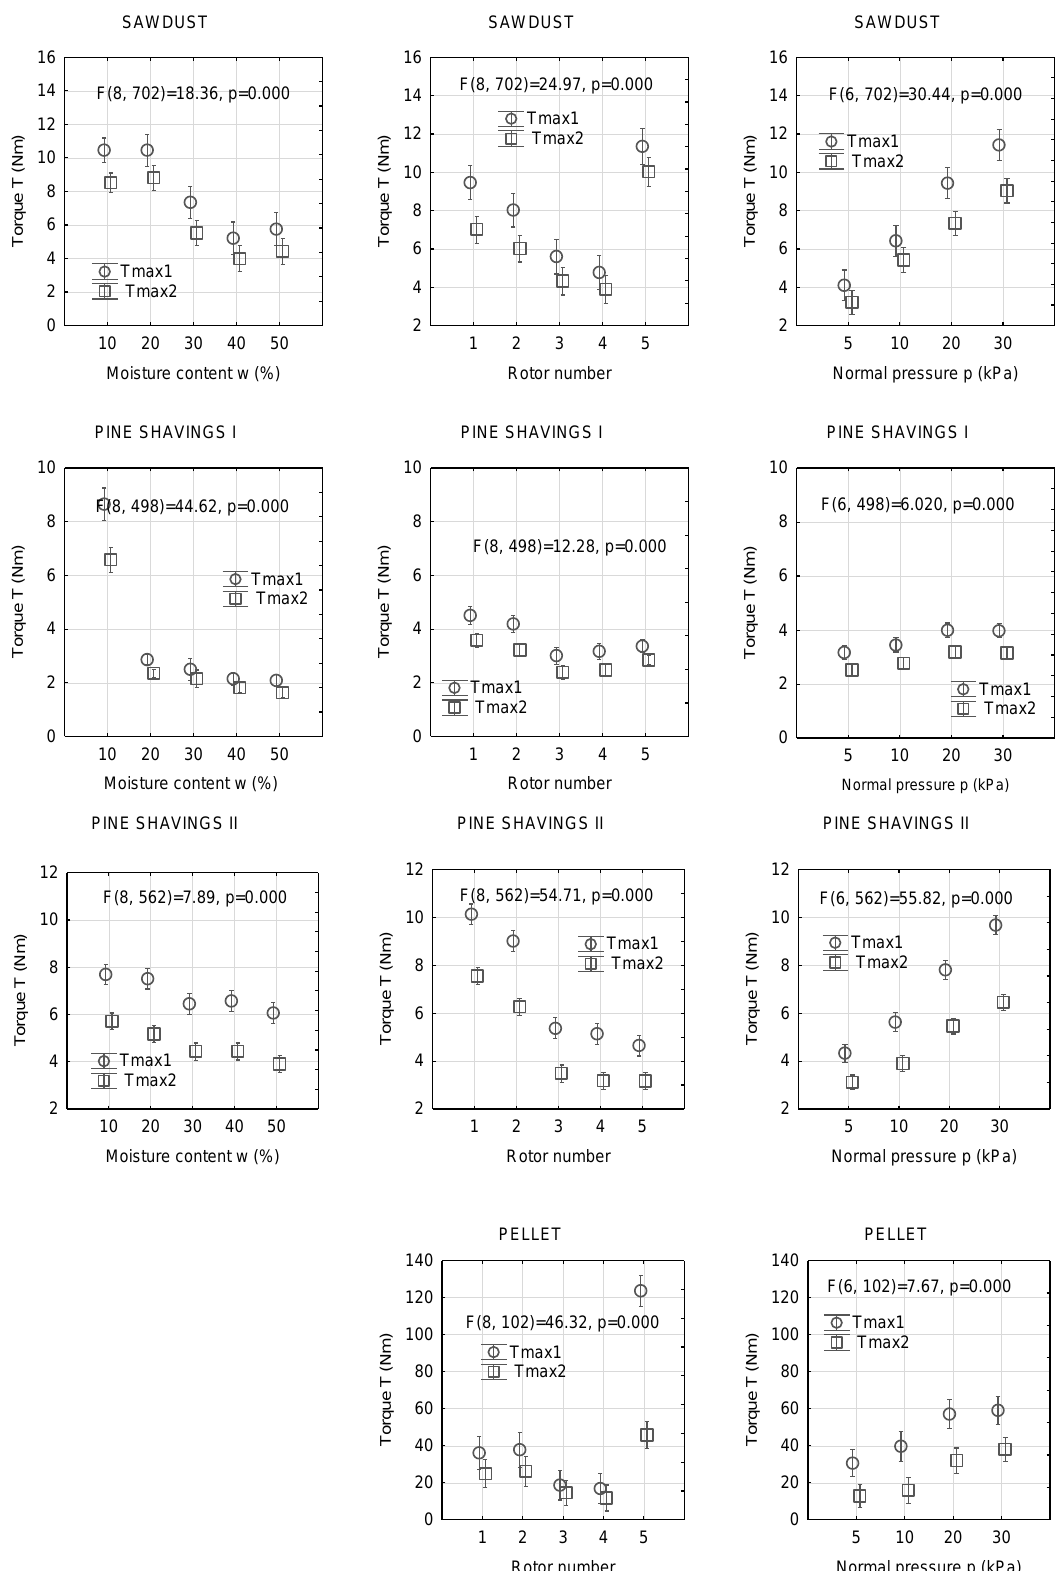
Figure 7. Mean value of maximal shear torques with 0.95 confidence intervals in dependence on moisture content, rotor number, and normal pressure.